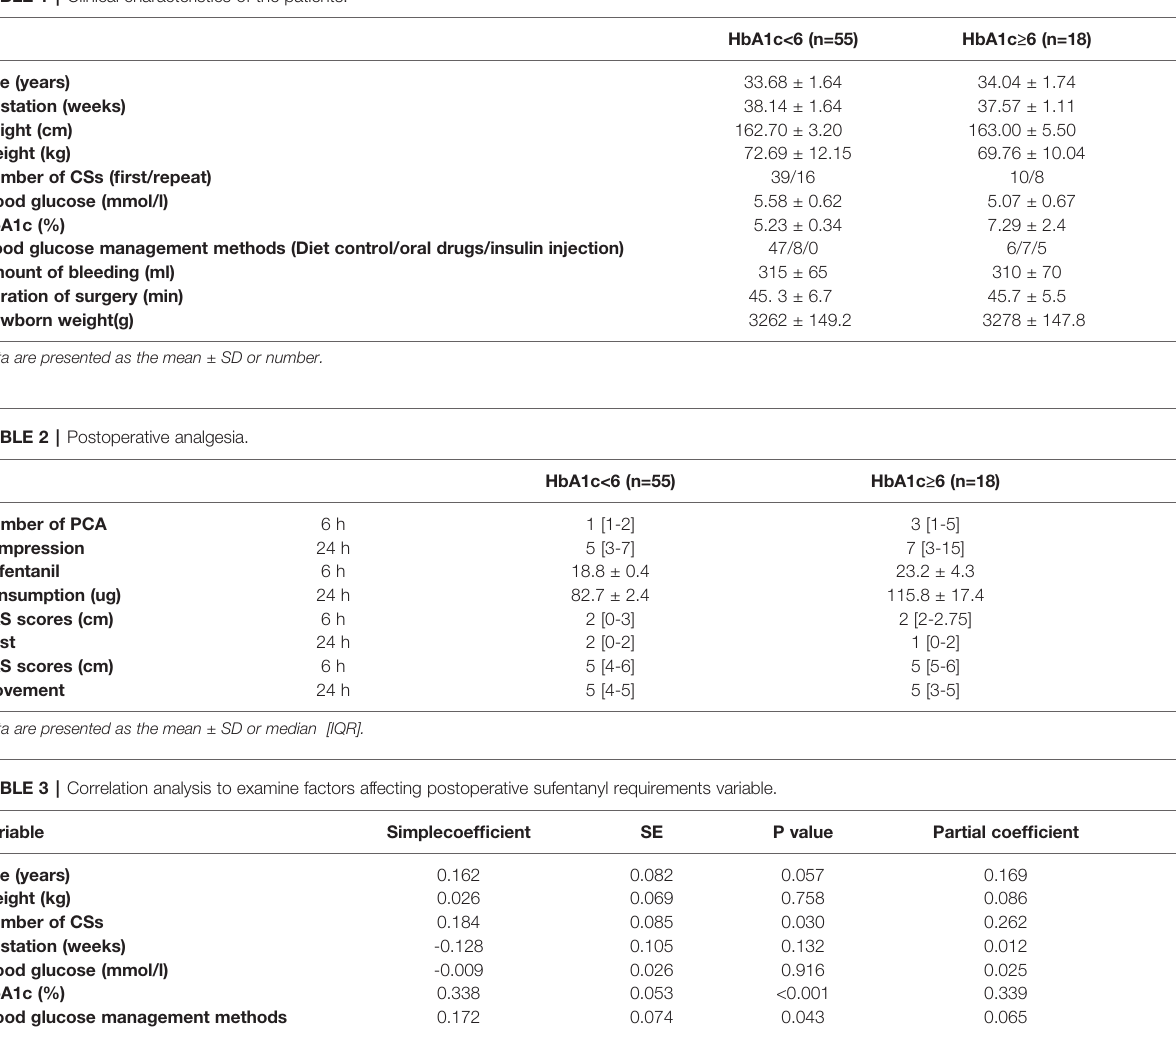
TABLE 1 | Clinical characteristics of the patients.